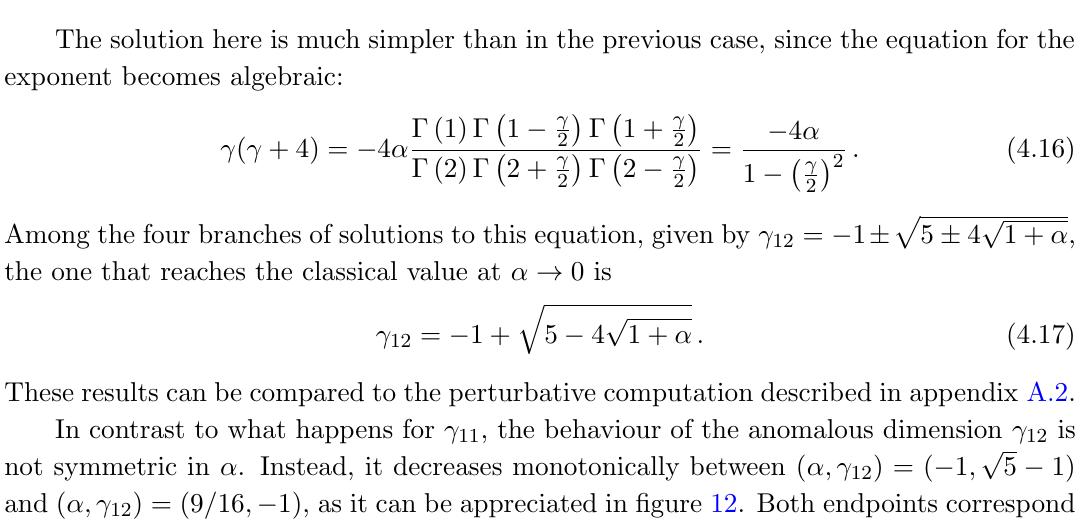
Figure 12 . Convergence of the perturbative expansion to the exact result obtained for the anoma- lous dimension (cid:13) 12 . The thin lines are truncated sums of the perturbative expansion at increasing orders. The red line is the 22nd order, the highest the authors deemed appropriate to calculate. The thick black line is the exact result. Notice that the segment (cid:11) 2 ( (cid:0) 1 ; (cid:0) 9 = 16) lies manifestly outside the radius of convergence of the perturbative